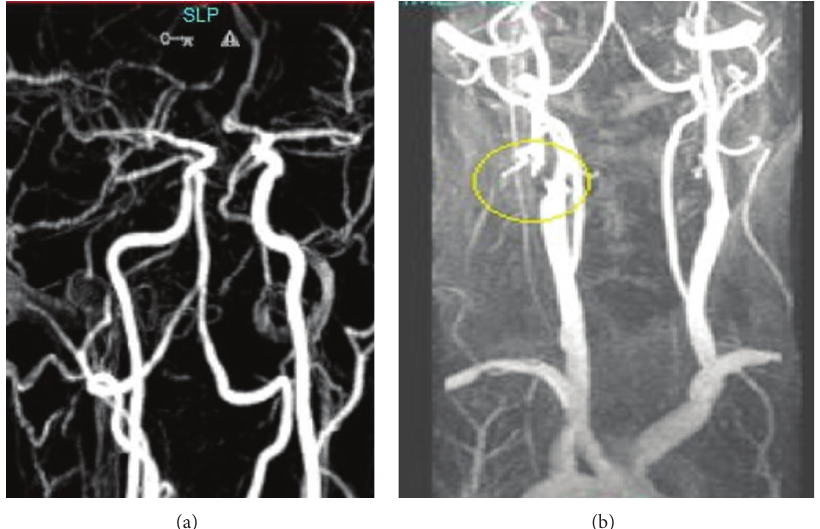
Figure 2: (a) Cranial MR angiography showed left fetal type PCA. (b) Cervical MR angiography showed critical stenosis on left proximal internal carotid